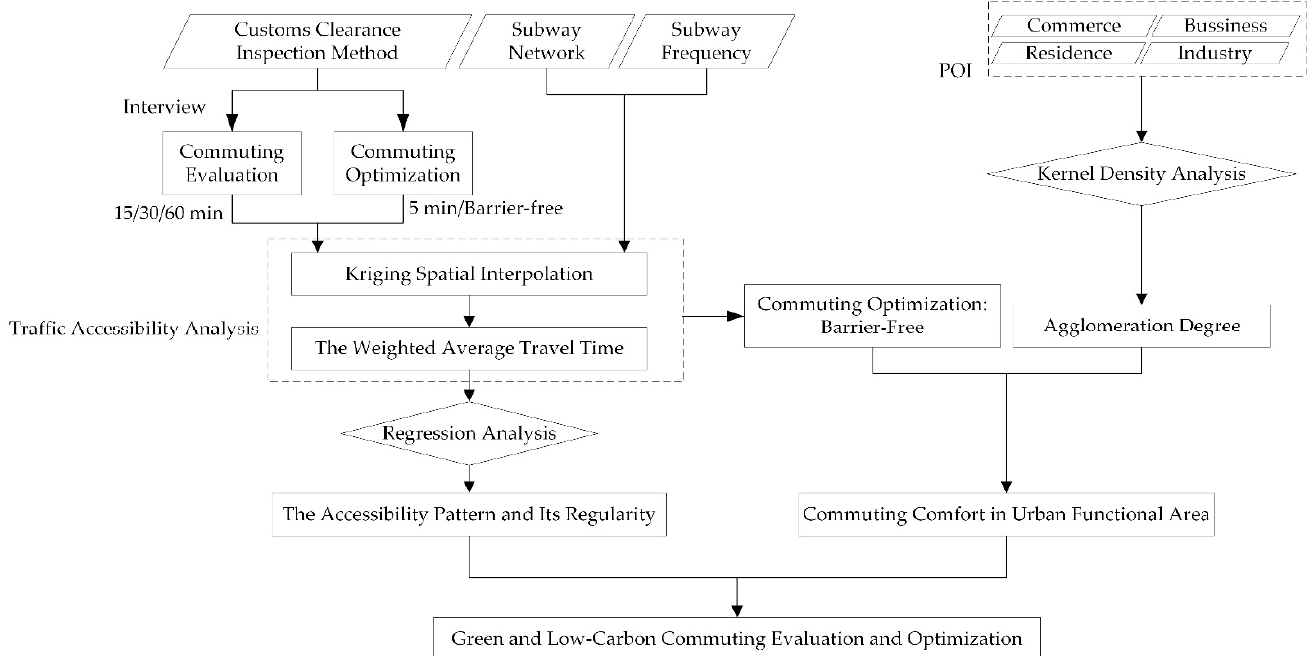
Figure 2. Research design.